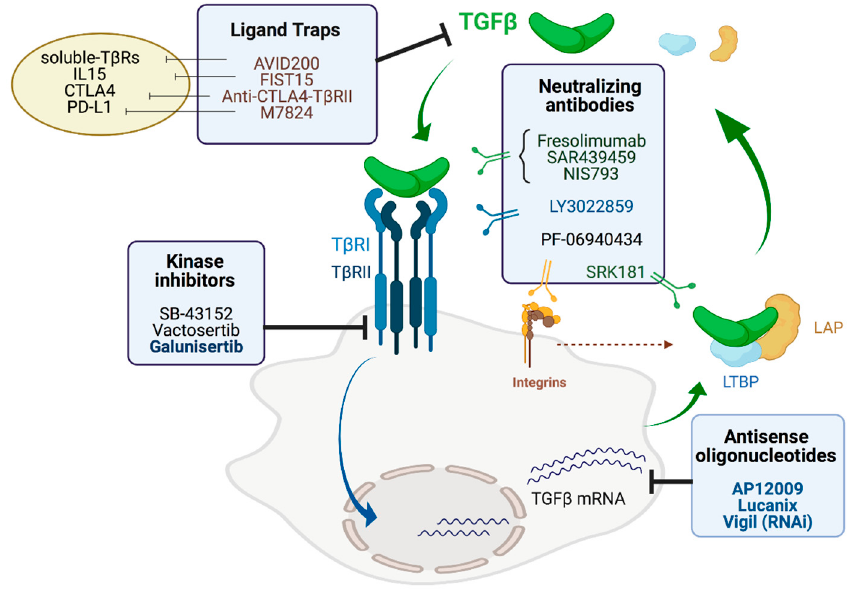
Figure 3. Schematic representation of the different strategies targeting TGF- β signaling for cancer therapy. According to their mechanism of action, directed against TGF- β expression, cytokine blockade or signaling inhibition, these strategies fall under different categories: (i) Antisense oligonucleotides; (ii) Neutralizing antibodies; (iii) Ligand traps; (iv) Small molecule inhibitors (kinase inhibitors). LAP: Latency Associated Peptide, LTBP: latent TGF- β binding proteins. Figure was created with BioRender.com.